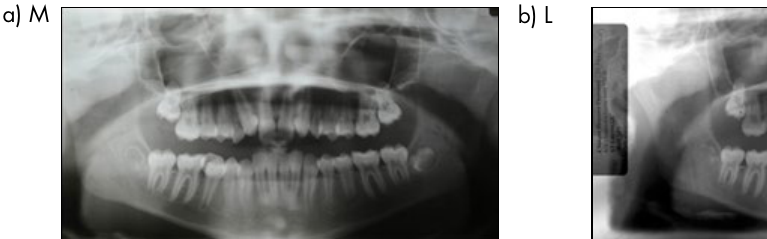
Figure 2. Pretreatment models.